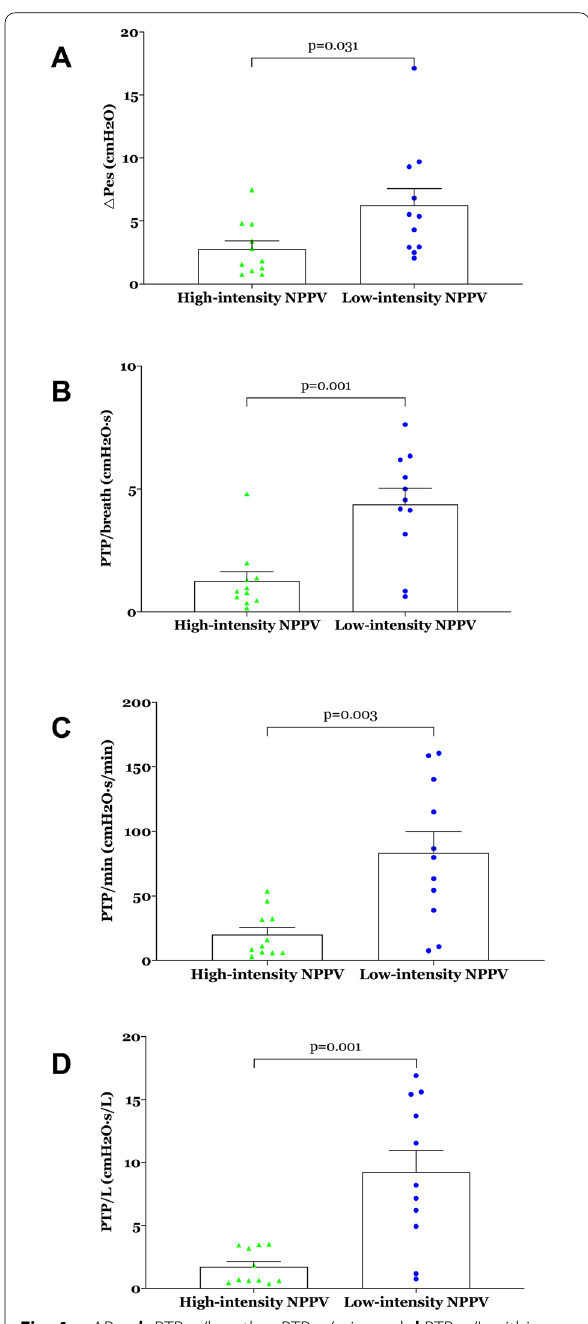
Fig. 4 a ΔPes, b PTPes/breath, c PTPes/min, and d PTPes/L within 24 h after randomisation. Values are individuals, means,